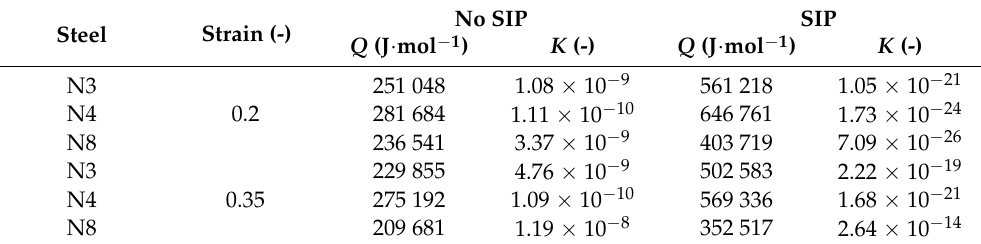
Figure 4. Dependence of t 0.5 on the reciprocal thermodynamic temperature: ( a ) without SIP and ( b ) with SIP (steel N4, e = 0.35). Table 4. Values of Q and K in the equation to describe t 0.5.